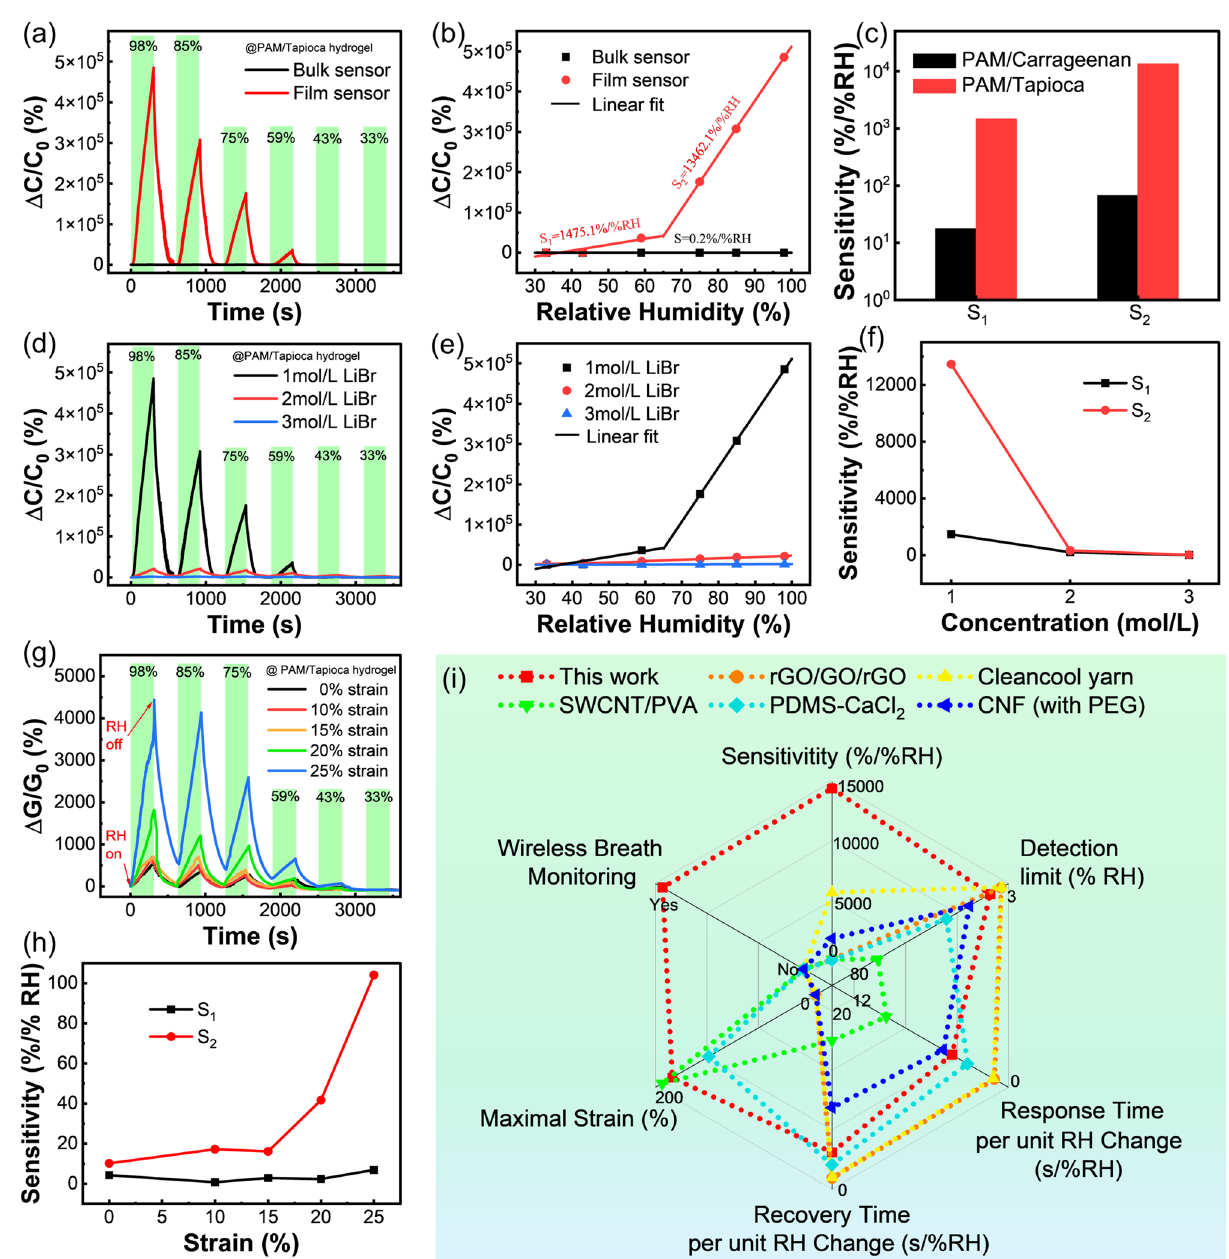
Fig. 6 a Time-dependent responses (capacitance) and b piecewise fitting of the response of PAM/Tapioca DN hydrogel bulk and film sensors. c Sensitivity comparison of the two hydrogel sensors. d Dynamic response (capacitance) curves, e piecewise fitting of the response, and f sensitiv- ity comparison of hydrogel film sensors soaked in 1, 2, and 3 mol L −1 LiBr solutions. g Dynamic response (conductance) curves and h sensitiv- ity comparison of hydrogel film sensor at 0, 10, 15, 20, and 25% tensile strains. i The radar chart comparing the performance of this humidity sensor with that of